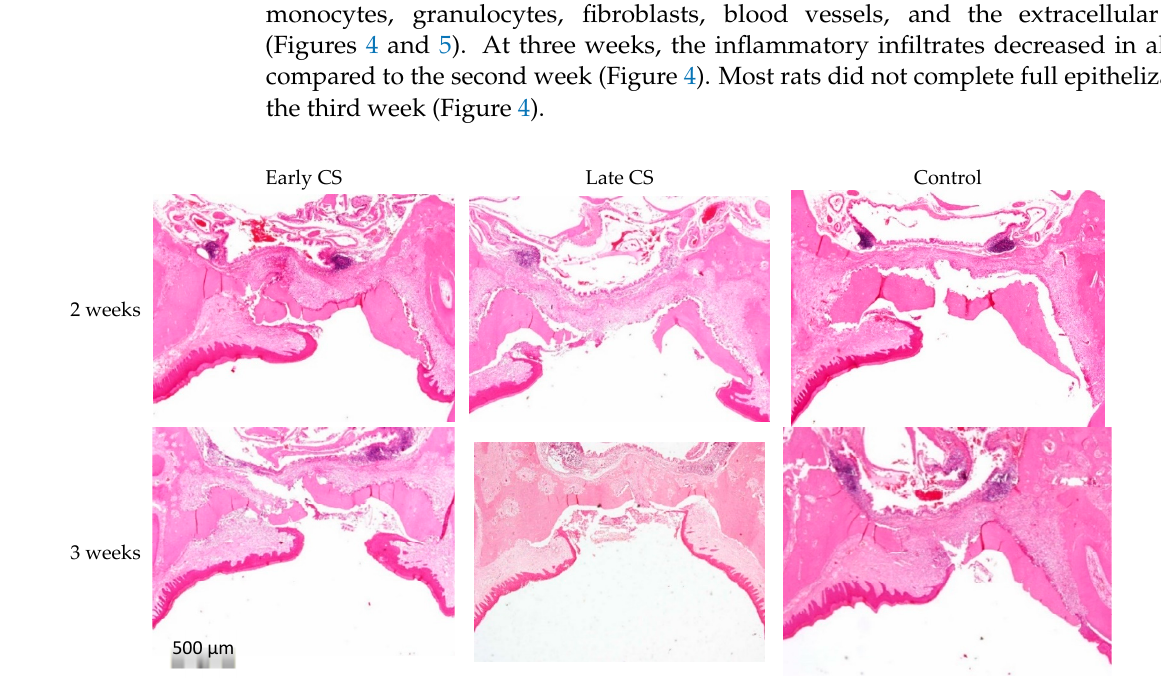
Table 2. Mean inflammation score at two and three weeks.